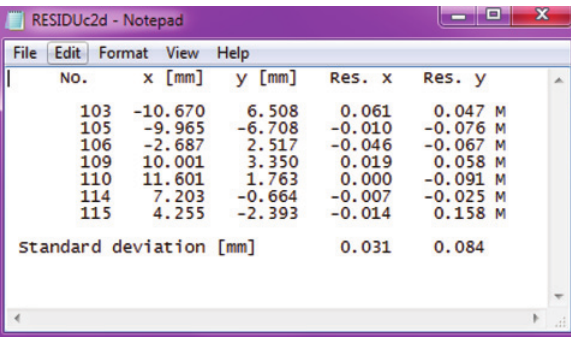
Fig. 8. Results of right image exterior